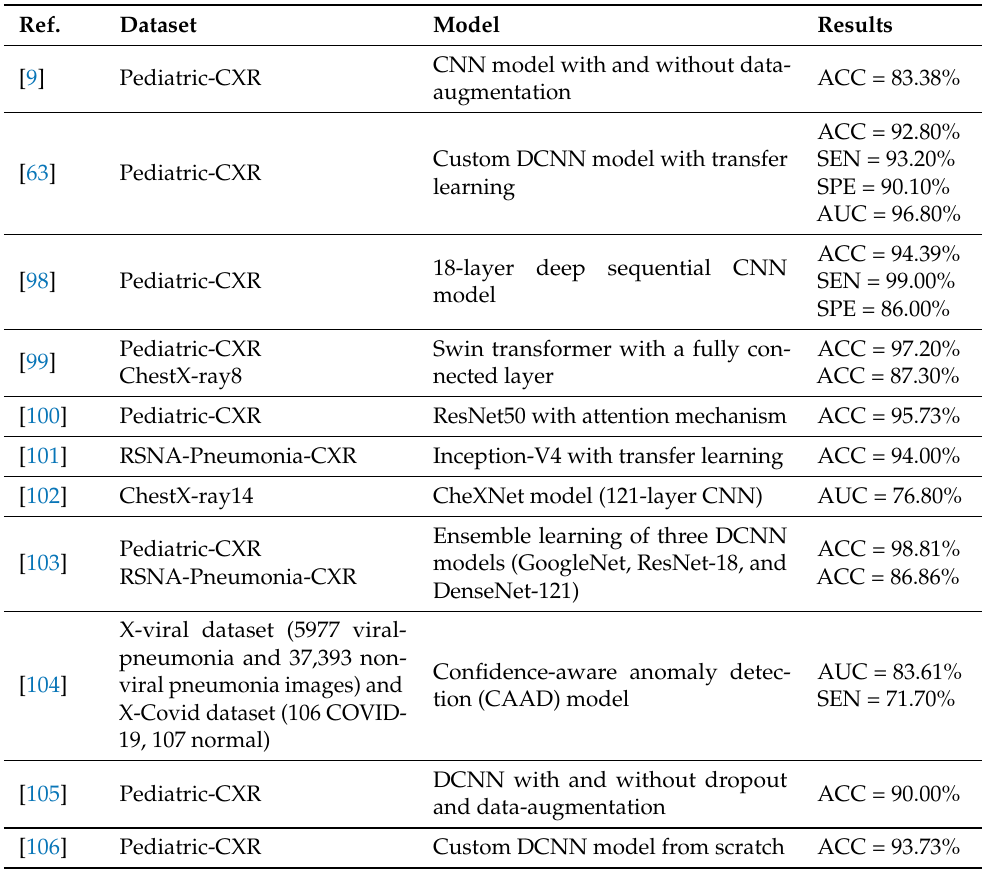
Table 7. Summary of different DL architectures used for pneumonia